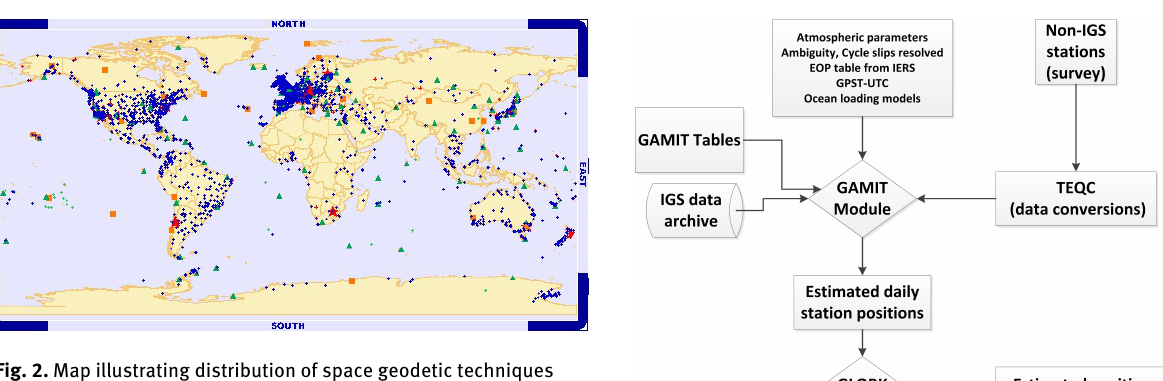
As a first step, all sessions where HartRAO participated were selected and processed, using a simple parameteri- sation. The primary function of the first processing step is to find corrupted sessions. Also outlier files were created and used in further processing. The VLBI reference frame 2008 (VTRF2008) was used, which is derived from VLBI observations before 2008. Station coordinates were esti- mated using the "No Net Rotation" and "No Net Transla- tion" approach. Not all sessions are suitable for estimating station pa- rameters, thus certain exclusion criteria have to be found.